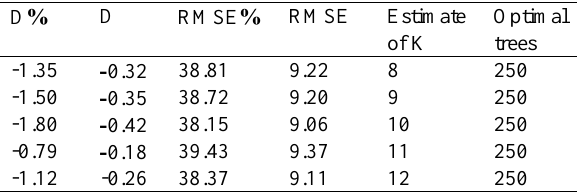
estimating basal area using only spectral data. The results revealed that modeling with 11 variables in each node (k=11) had a minimum of RMSE and was selected as optimal K in estimating the basal area using the Pleiades data. Table.4: The evaluation of the random forest to determine the most appropriate parameter for basal area using spectral and auxiliary data. Table 4 shows the evaluation criteria resulted from the random forest with different number of k in